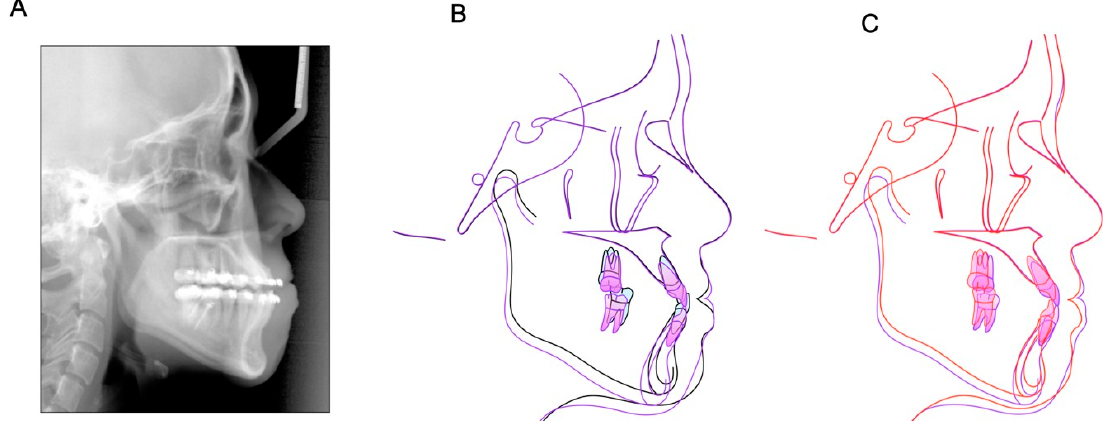
Figure 17. Case 2, ( A ), Lateral cephalogram in the 4th month of treatment right after the correction of anterior crossbite; ( B ), Cephalometric superimpositions of pretreatment and the 4th month show that most of the correction of anterior crossbite was due to proclination of the upper incisors, even though the mandibular arch was distalized a bit with TSADs on the buccal shelves; ( C ), Cephalometric superimpositions of posttreatment and the 4th month shows full arch distalization of both maxillary and mandibular arches to reduce the protrusion after anterior crossbite correction.